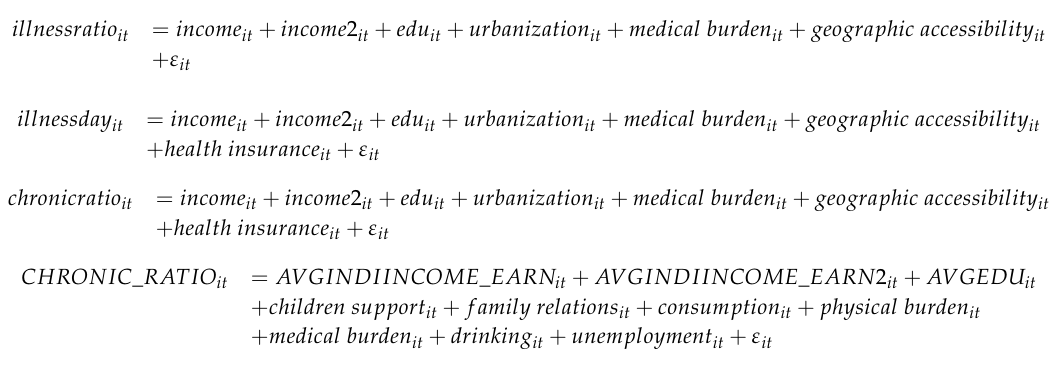
Table A4, and Note: 1. loadings are colored by column. Larger correlations have deeper red colors. Table A5 display the loading matrices with component names. The final model specifications for different health outcomes